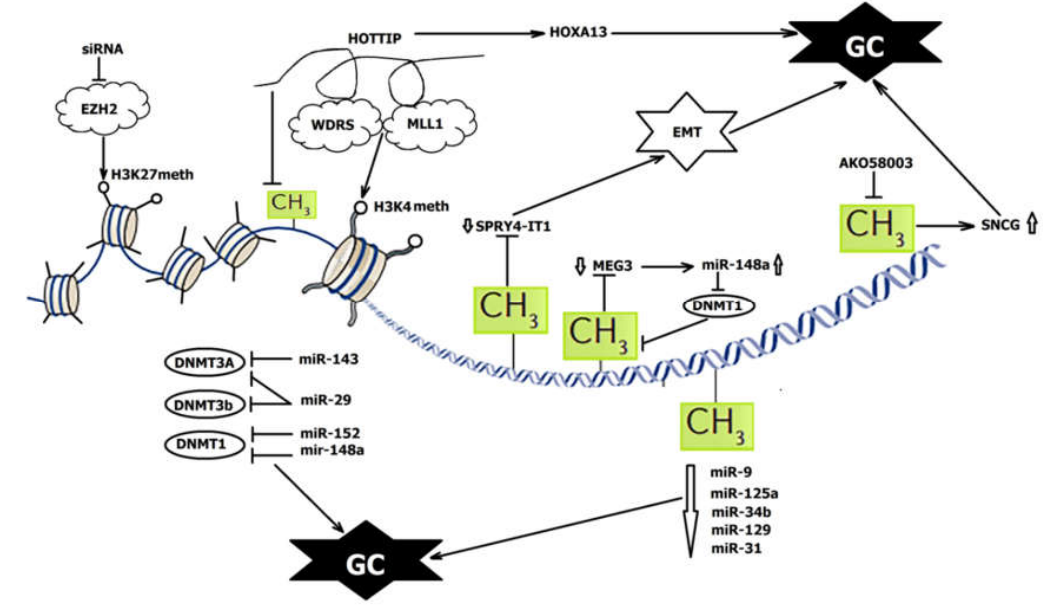
Figure 1. The interplay between DNA methylation and ncRNAs in GC epigenetic regulation. GC—gastric cancer; EMT— epithelial–mesenchymal transition; arrows—activation; bars—suppression.